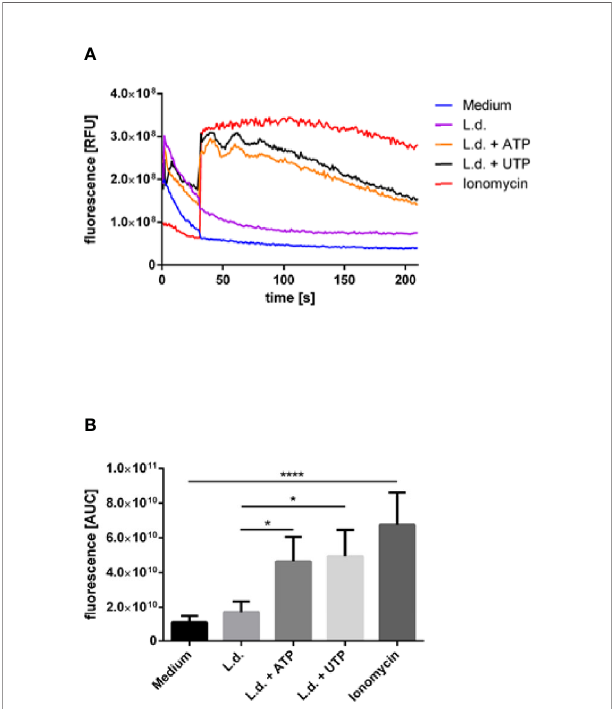
FIGURE 6 | The effect of extracellular ATP and UTP on the intracellular Ca 2+ -concentration in L. donovani -infected neutrophils. Neutrophils were labeled with the fl uorescent Ca 2+ -sensitive indicator Fluo-4 AM and infected with L. donovani promastigotes. Infected neutrophils were exposed to ATP (500 µM) or UTP (500 µM) and the fl uorescence intensity was assessed for 3 min by using fl ow cytometry. The stimuli were added at the time point 30 s of the fl ow cytometry analysis. Fluo-4-labeled non-infected cells were used as negative controls, Fluo-4-labeled non-infected cells exposed to ionomycin (10 µM) were used as positive controls. (A) Representative kinetic curves of Fluo-4 AM fl uorescence in neutrophils. (B) Fluo-4 AM fl uorescence shown by calculating the area under the curve (AUC) values calculated between the time points 30 sec and 210 sec. Statistical analysis by ordinary one-way ANOVA with a post hoc Turkey ’ s test. Asterisks above the bars indicate signi fi cance compared to untreated cells. n=3, *p ≤ 0,05, ****p ≤ 0,0001.